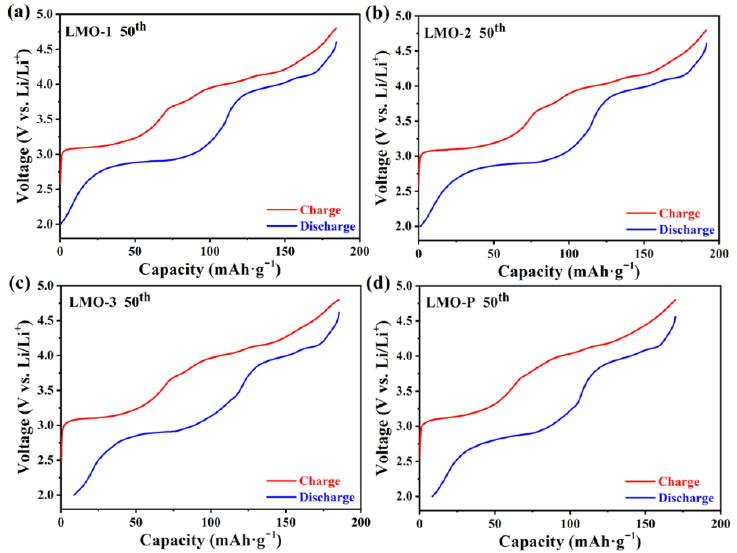
Figure 7. The charging – discharging curves of various samples in the 50th cycle at potential range of 2.0 −4.8 V ( a − d ) .